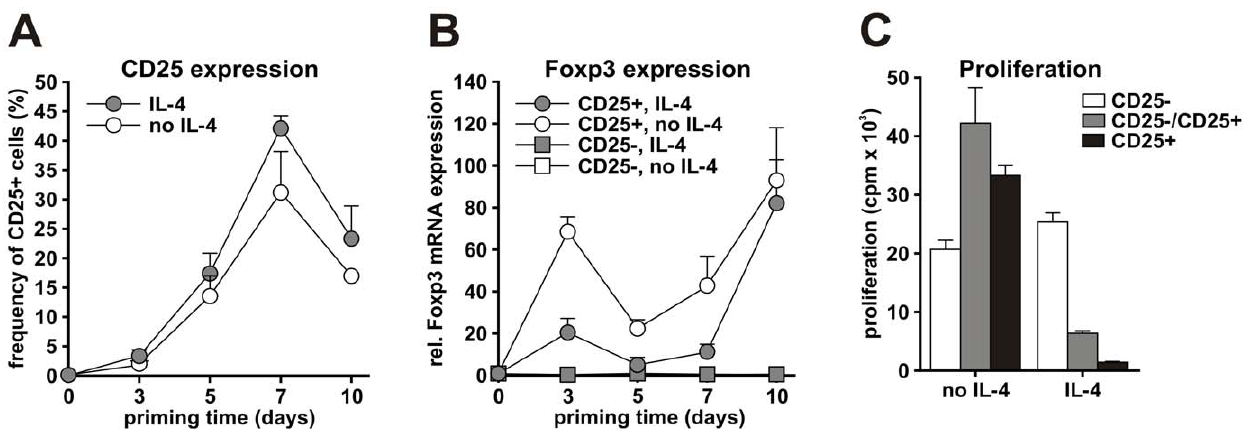
Figure 1. CD25 + iTreg development. Human naive CD4 T cells depleted of CD25 + cells were cultured with autologous irradiated feeder cells for 10 days in the presence or absence of IL-4. (A) At days 3, 5, 7 and 10 cells were analyzed for CD25 expression. (B) CD25 + and CD25- populations were magnetically sorted at the days indicated. Foxp3 mRNA expression was assessed in both CD25 + and CD25- populations by real-time PCR and its relative expression was calculated in relation to cyclophilin mRNA. (C) At day 10, the proliferative and suppressive capacities of CD25 + and CD25- cells in response to CD3 stimulation were assessed by thymidine incorporation. Data are shown as a mean 6 SEM of three independent experiments (A, B) or as a mean 6 SD of one representative experiment performed in triplicates (C).